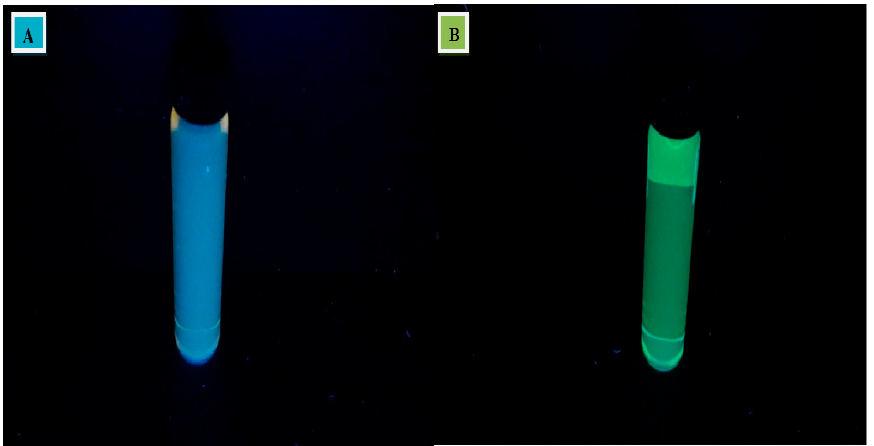
Figure 10. Tapioca powder as source of fluorescent carbon dots. ( a ) Carbon dots after synthesis emitting blue fluorescence. ( b ) Carbon dots emitting green fluorescence after 3 months of synthesis.